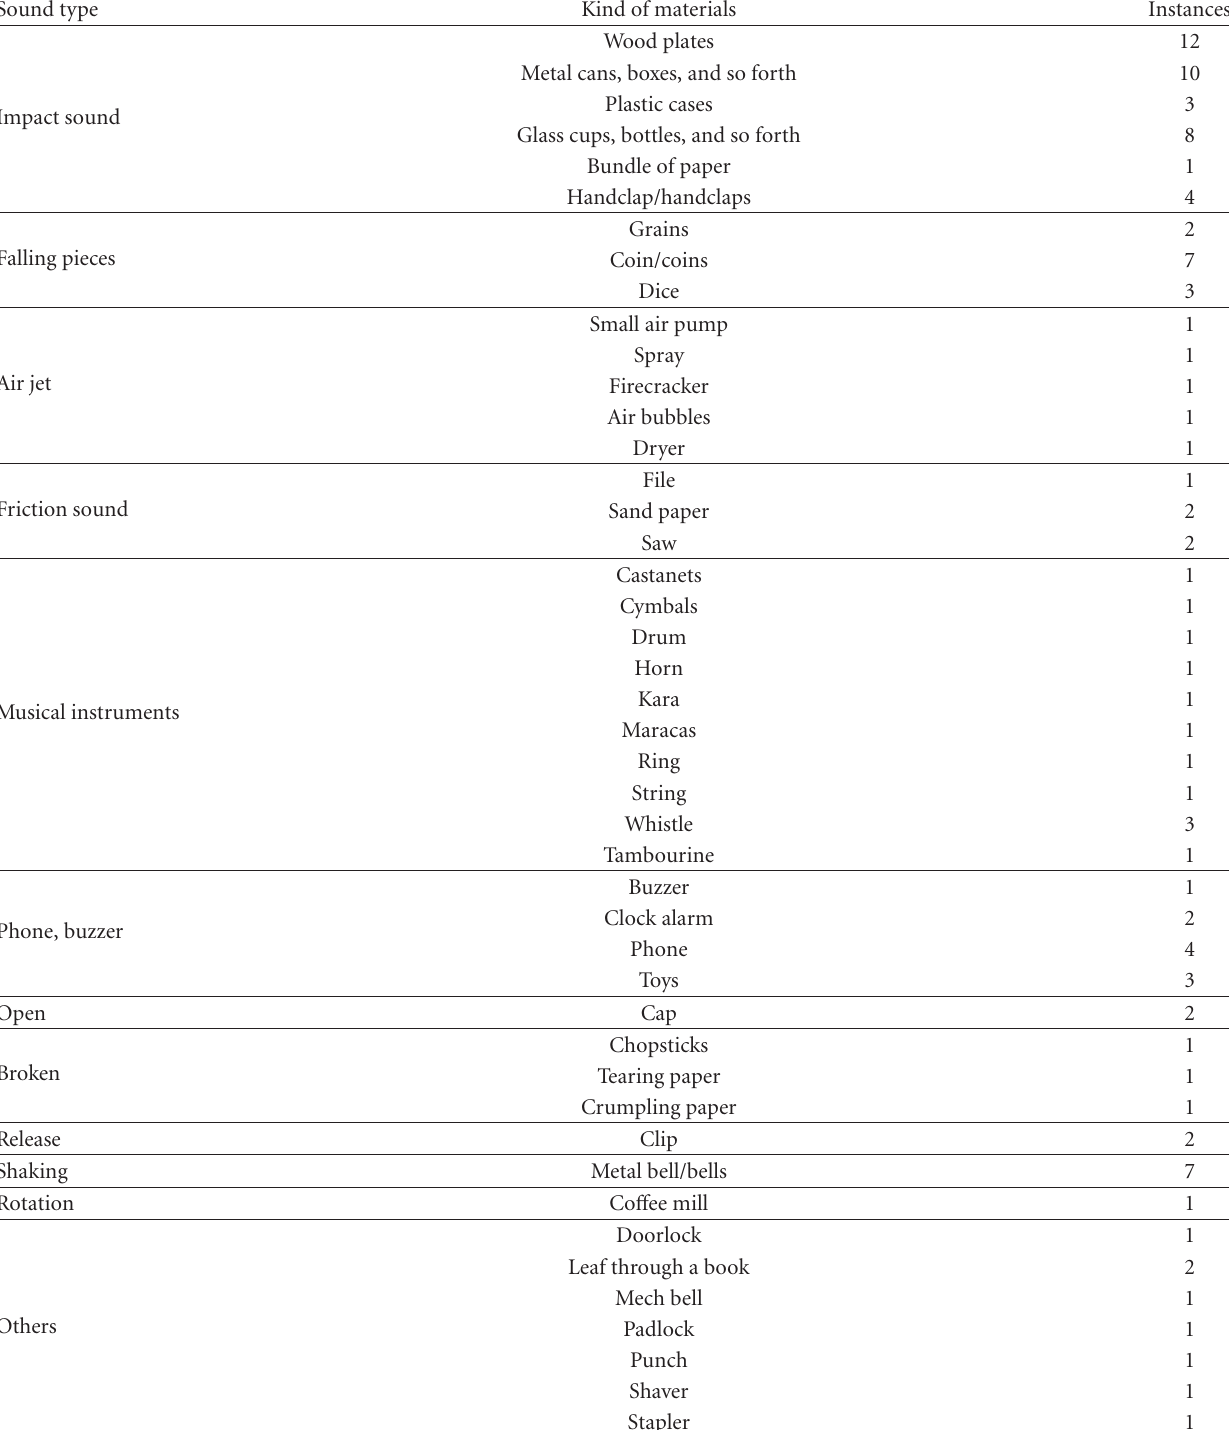
Table 1: The RWCP environmental sound